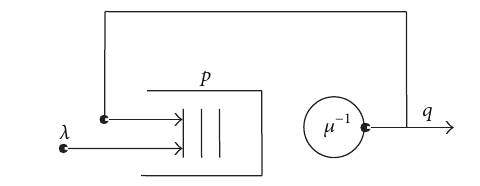
Figure 6: Bernoulli feedback queueing